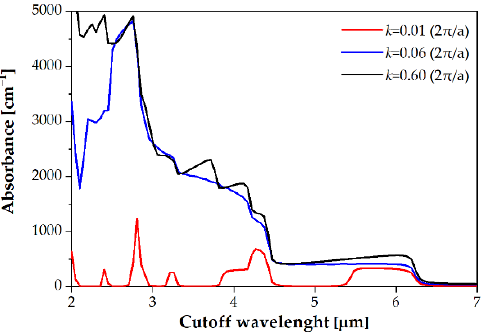
Figure 2. Theoretically calculated absorption coefficients versus wavelength for three wavevector ranges: k = 0.01 (2 π / a ), k = 0.06 (2 π / a ) and k = 0.6 (2 π / a ). Table 1. Parameters of the binary InAs and ternary InAs 0.70 Sb 0.30 materials at T = 150 K.